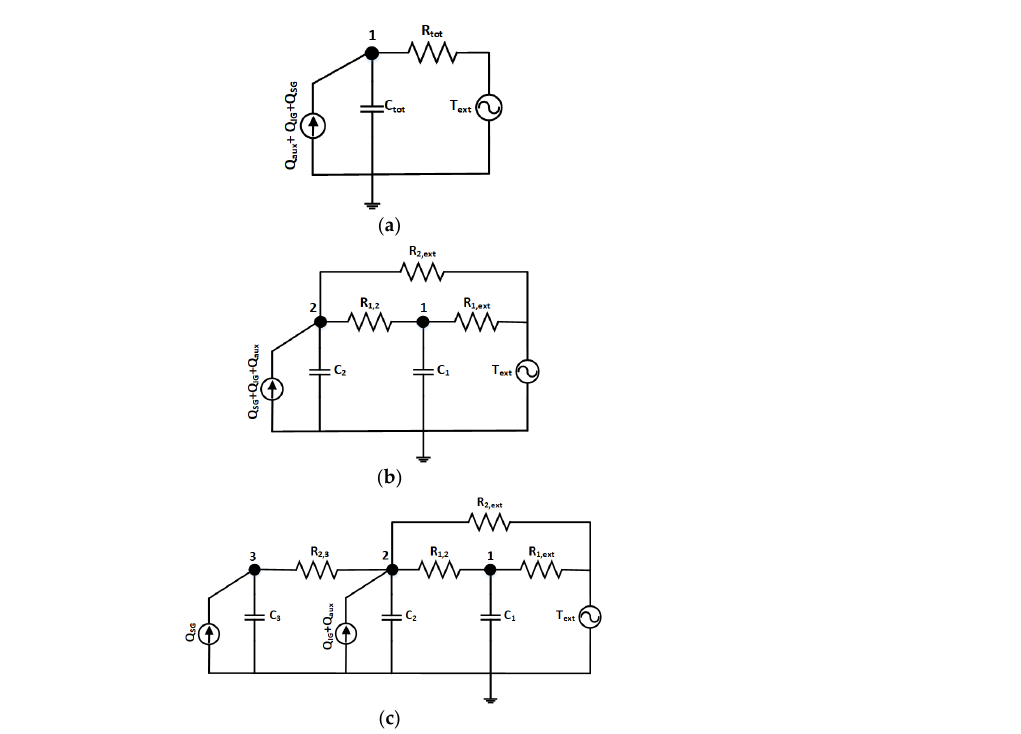
Figure 6. RC thermal network model: ( a ) first-order, ( b ) second-order, and ( c ) third-order models.